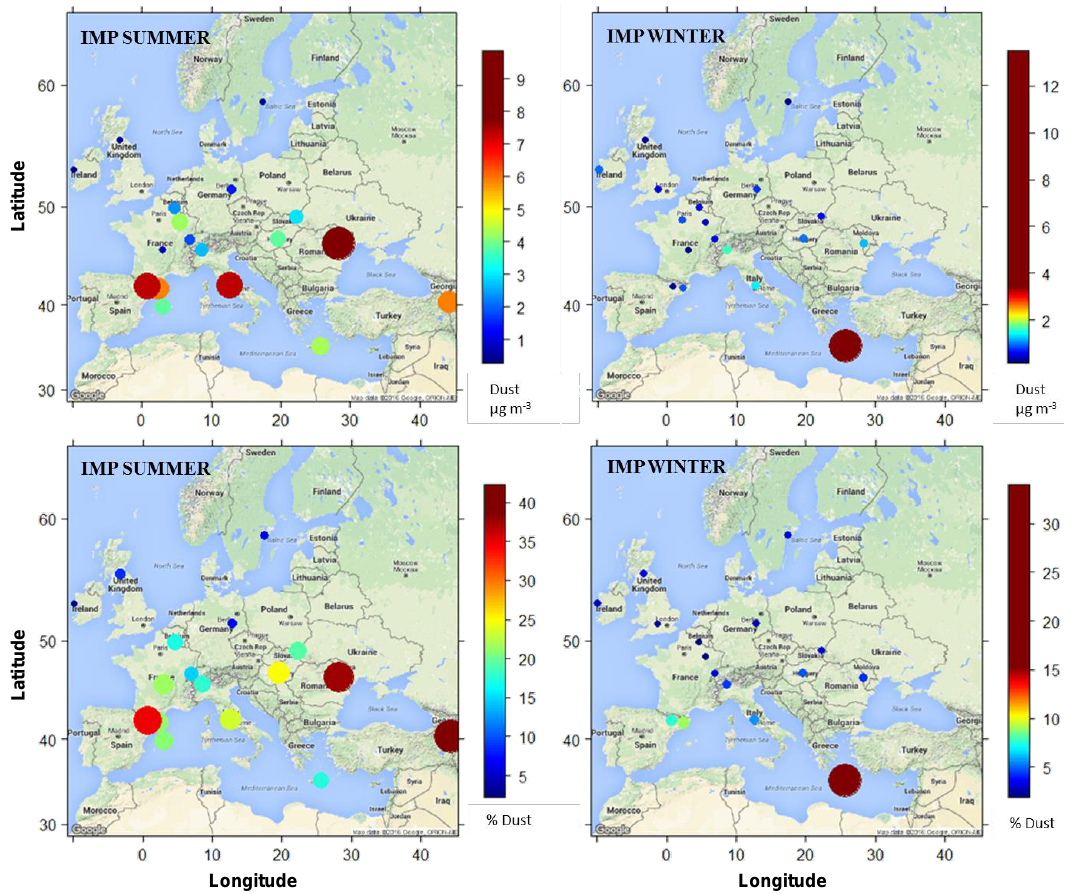
Figure 7. Spatial distribution of the average mineral dust concentration (µgm − 3 ) and its relative contribution (%) to PM 10 obtained at each site in the summer 2012 and the winter 2013 IMPs. The diameter of the circles is proportional to the concentrations and percentages.